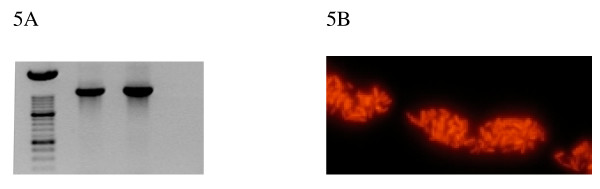
(A): Strain 1160/04 identified as E. sakazakii by the α-glucosidase based PCR assay (A); lane 1: DNA 100 bp marker, lane 2: positive control (E. sakazakii reference strain ATCC 29004), lane 3: E. sakazakii fruit powder isolate FSM 322, lane 4: negative control. (B) Positive VIT result of strain FSM 322